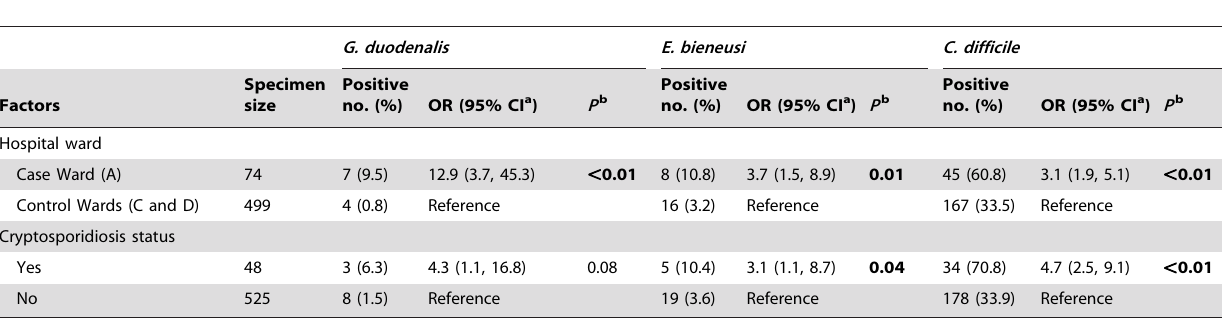
Table 1. Distribution of Giardia duodenalis , Enterocytozoon bieneusi , and Clostridium difficile infections in pediatric inpatients by ward and Cryptosporidium infection status.